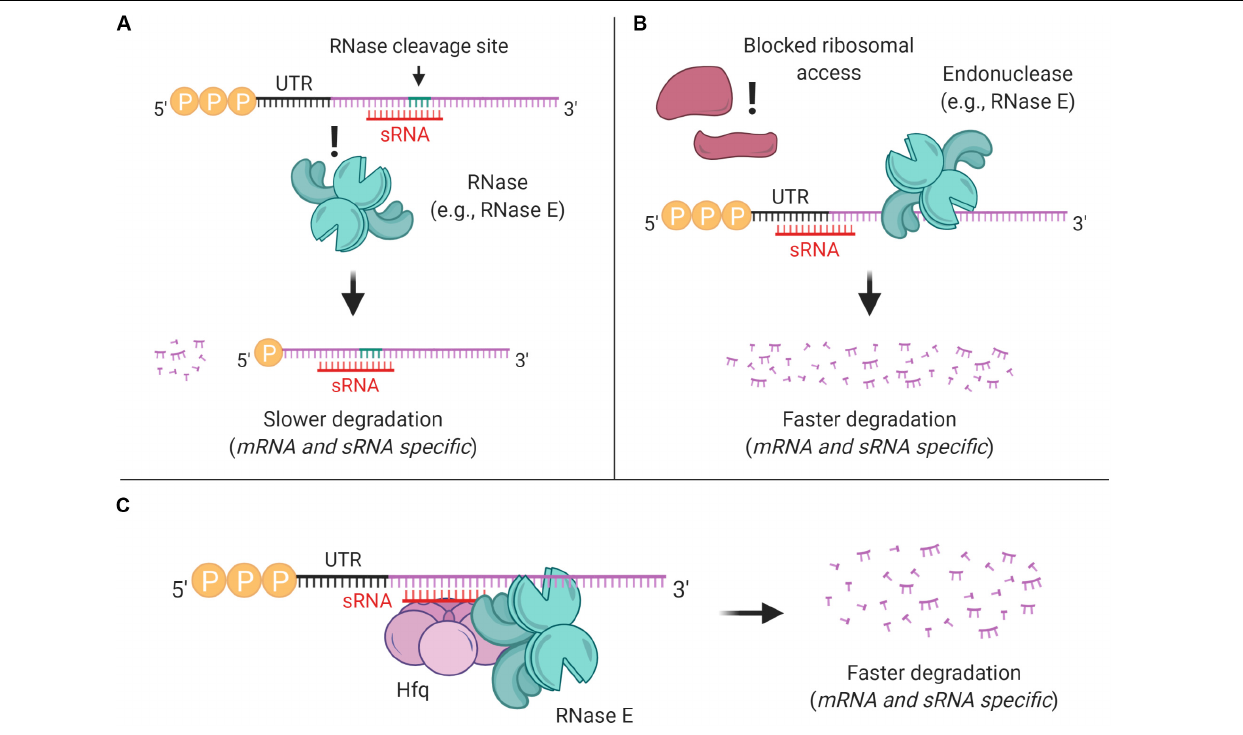
FIGURE 4 | sRNAs can affect mRNA stability through multiple mechanisms. (A) sRNA binding can mask preferred RNase cleavage sites, thereby stabilizing transcripts. (B) sRNA binding can block ribosome access to Shine-Dalgarno sites, reducing translation and typically destabilizing transcripts. (C) In E. coli and some other gram-negative bacteria, sRNA-mRNA pairing is often mediated by Hfq, which typically leads to mRNA